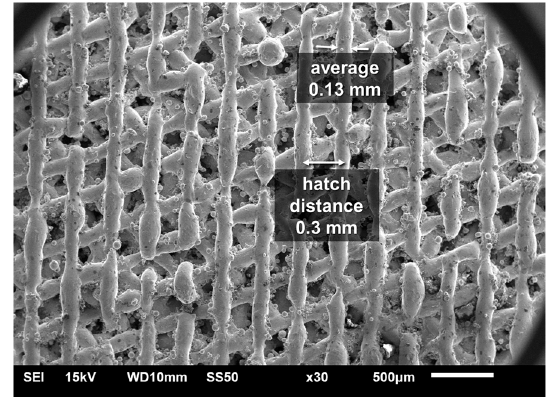
Table 1. Composition percentages of maraging steel powder for SLM [23].